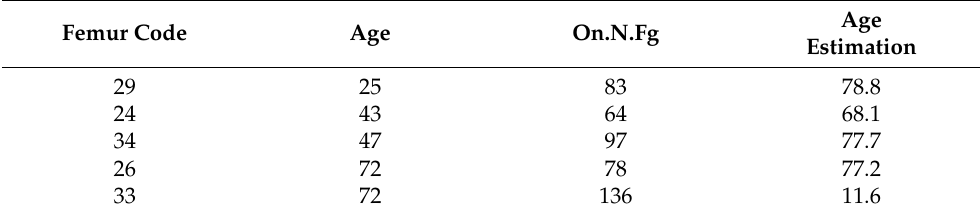
Table 9. Number of fragmented osteons and estimated ages by Kerley’s equation. Femur Code